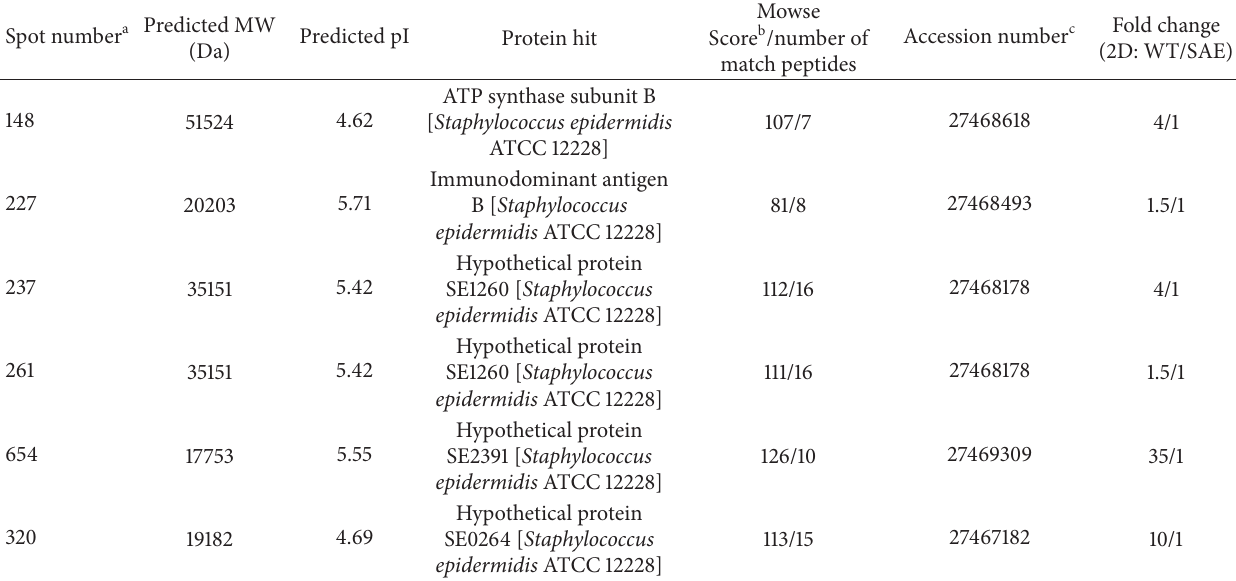
a Spots numbers correspond to the numbers in Figure 2. b Protein score was from MALDI-TOF/TOF identification. The proteins that had a score great than 72 ( 𝑃 < 0.05 ) were considered statistically significant. c Accession no. is the MASCOT result of MALDI-TOF/TOF searched from the NCBInr database. d A/N indicates the spot detected only in the protein extracts of S. epidermidis 1457 wild-type strain.